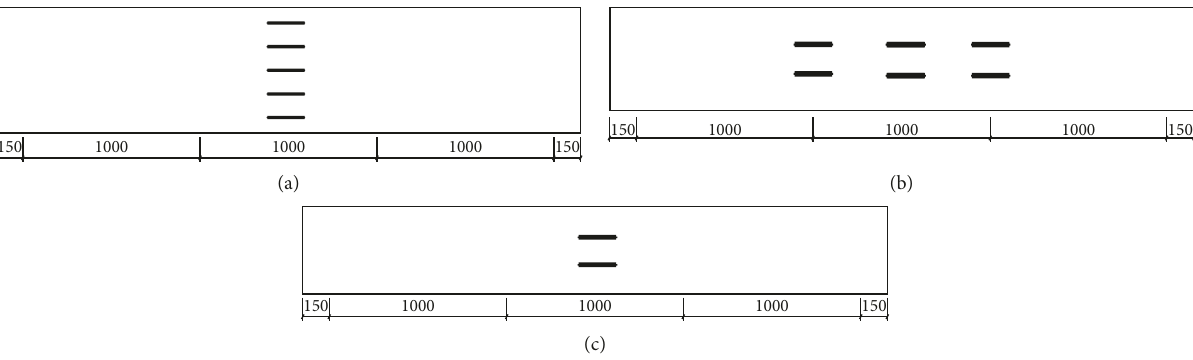
Figure 6: Strain gauge measuring position. (a) The side surface. (b) The bottom surface. (c) The top